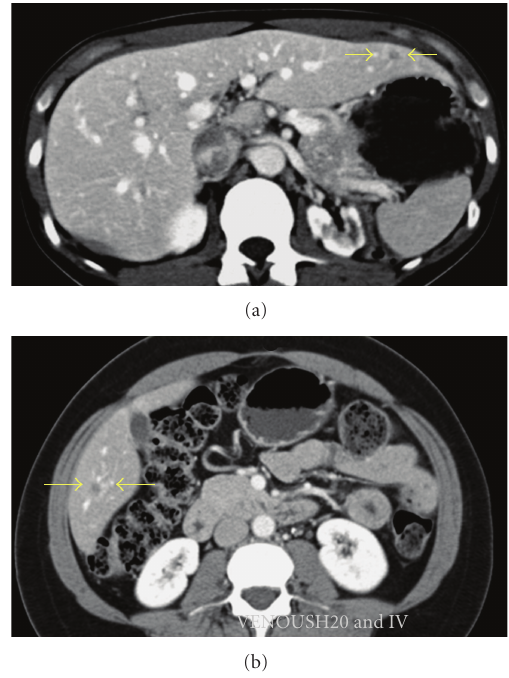
Figure 1: CRLMs accessible for straightforward MILR. (a) A hypodense CRLM in segments 2/3; (b) A hypodense CRLM in segment